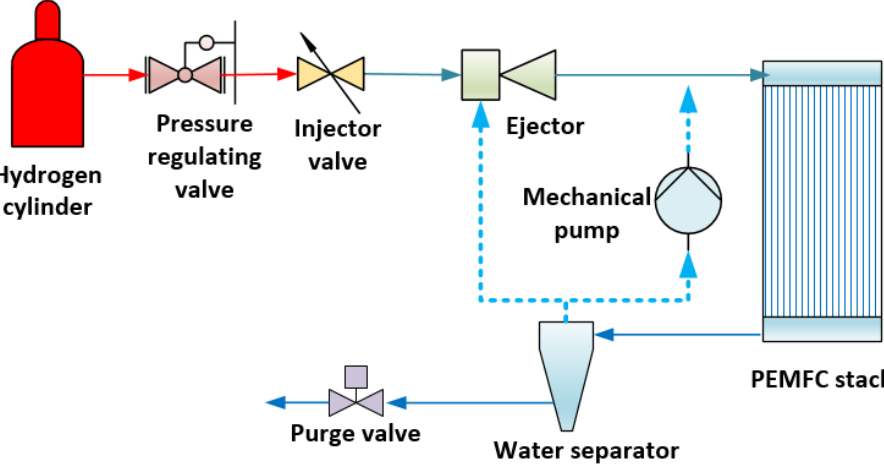
Figure 1. Schematic diagram of the hydrogen supply subsystem in a PEMFC system.